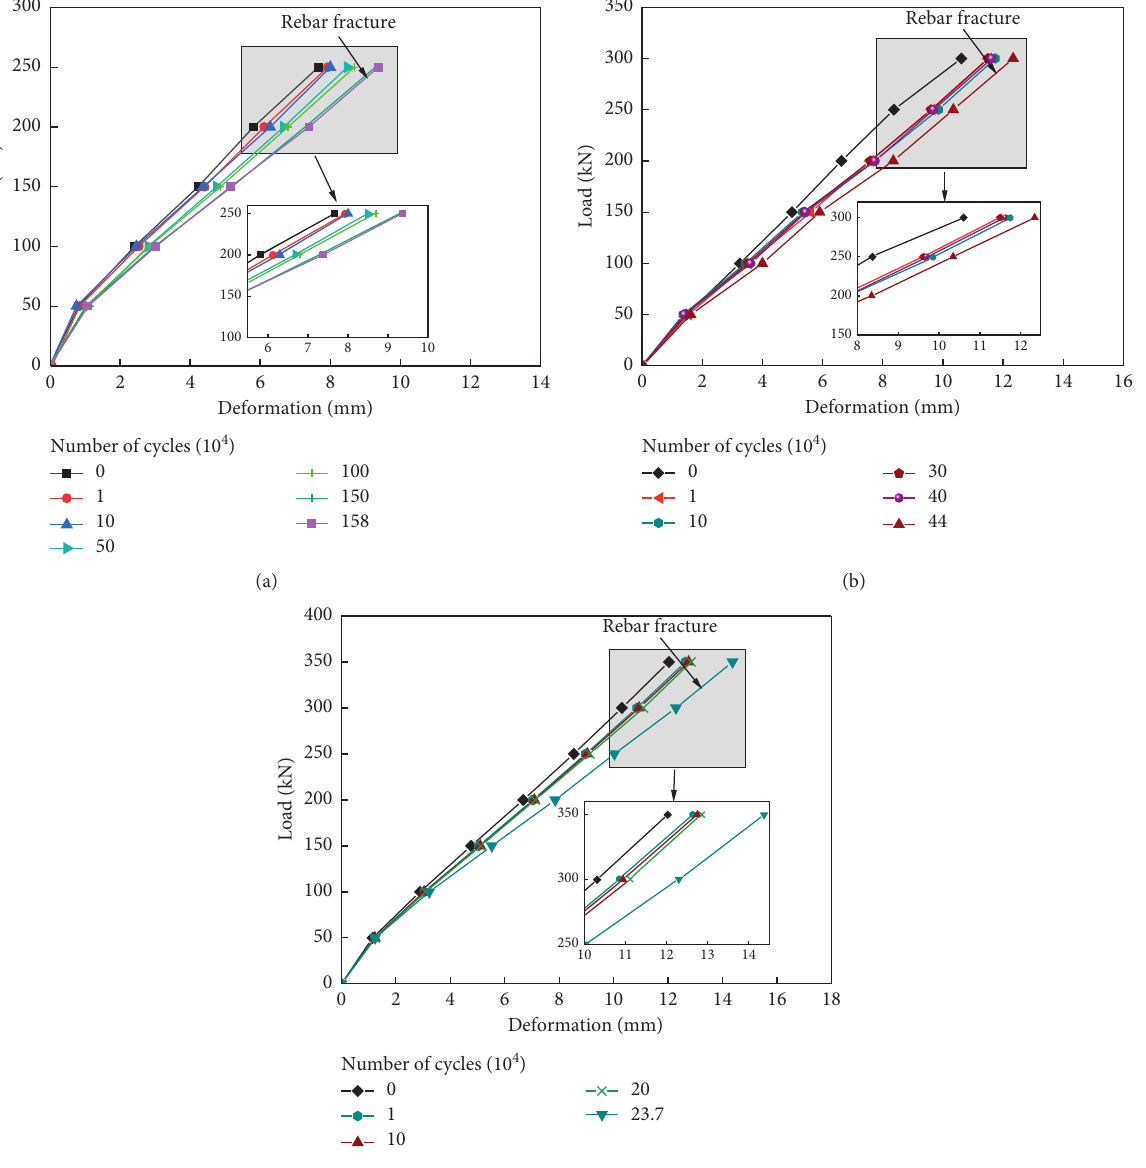
Number of cycles (10 4 )